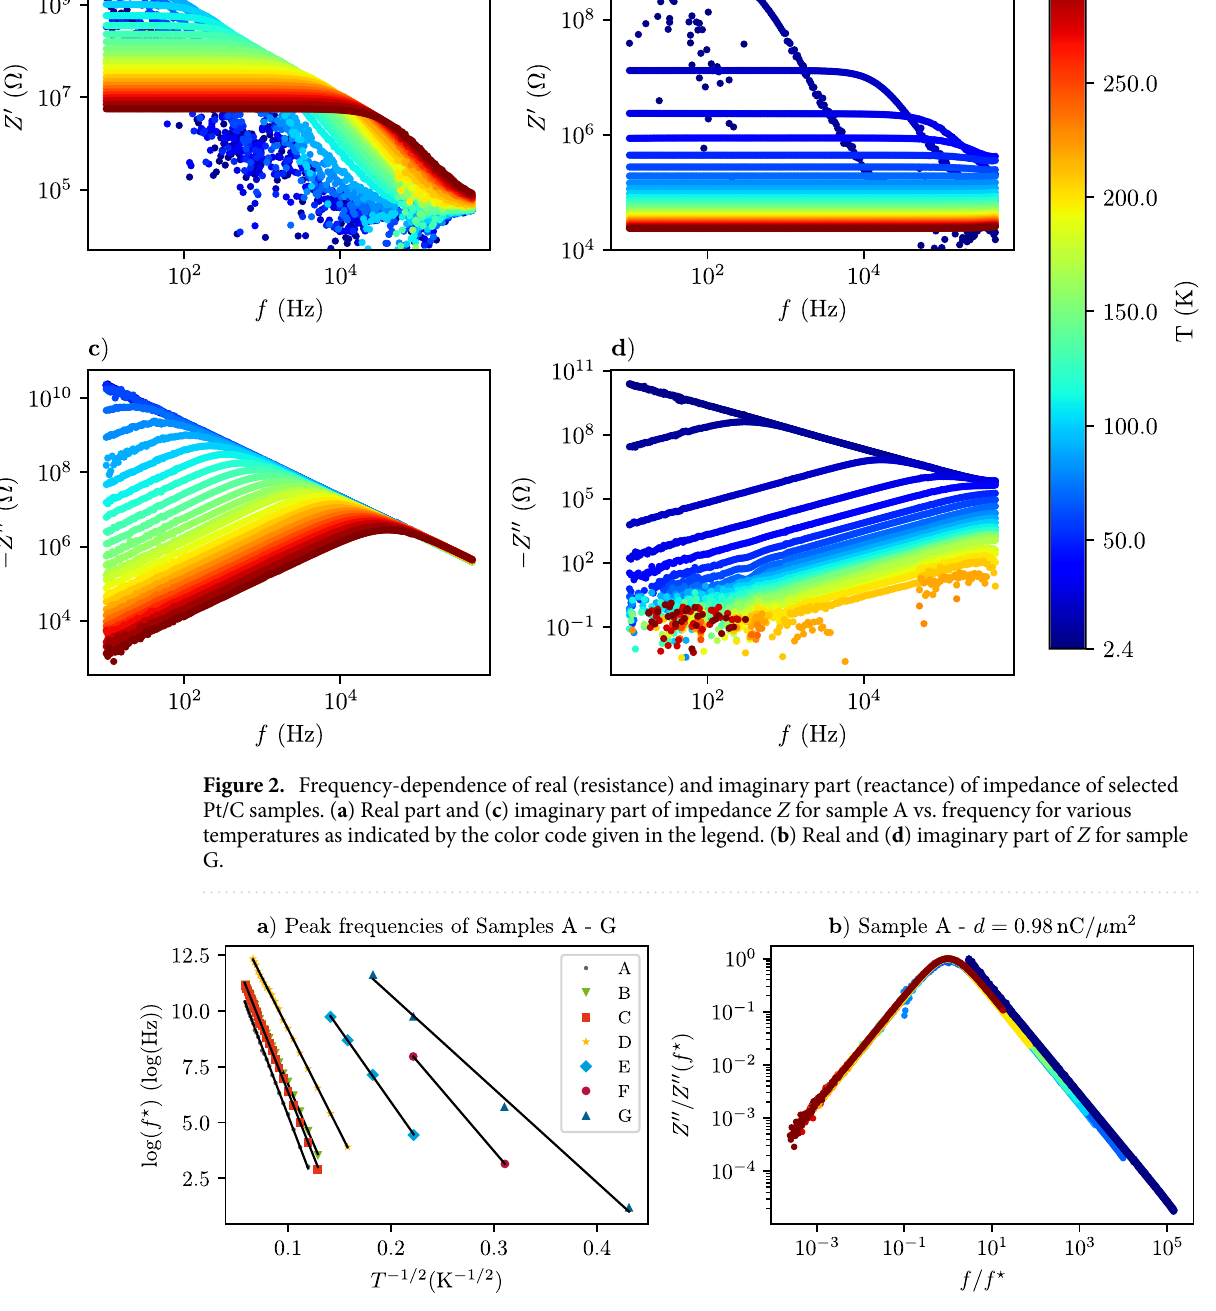
Figure 3. ( a ) Temperature-dependence of characteristic frequency f ∗ in log f ∗ vs. 1 / all samples, as indicated. The solid lines are fits to the data according to Eq. (5). ( b ) Scaled representation of reactance of sample A. See text for